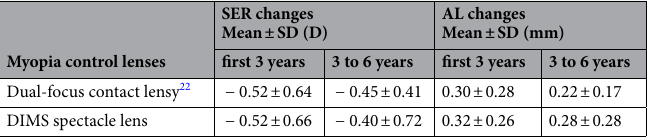
Table 4. Comparison of SER and AL changes with a dual-focus contact